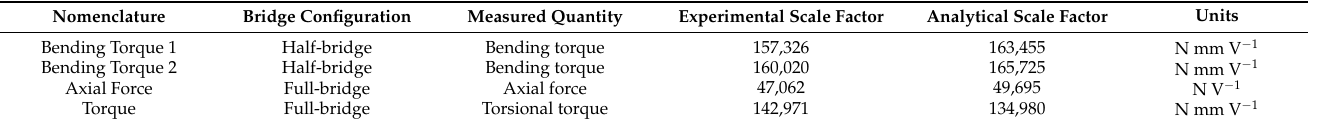
Table 2. Strain gauge calibration.